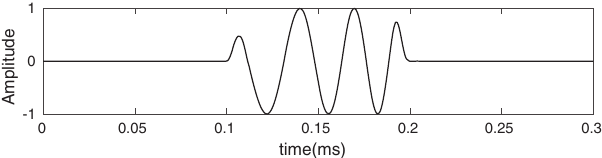
Figure 11. Signal ( “ linear chirp ” ) emitted by sources in numerical